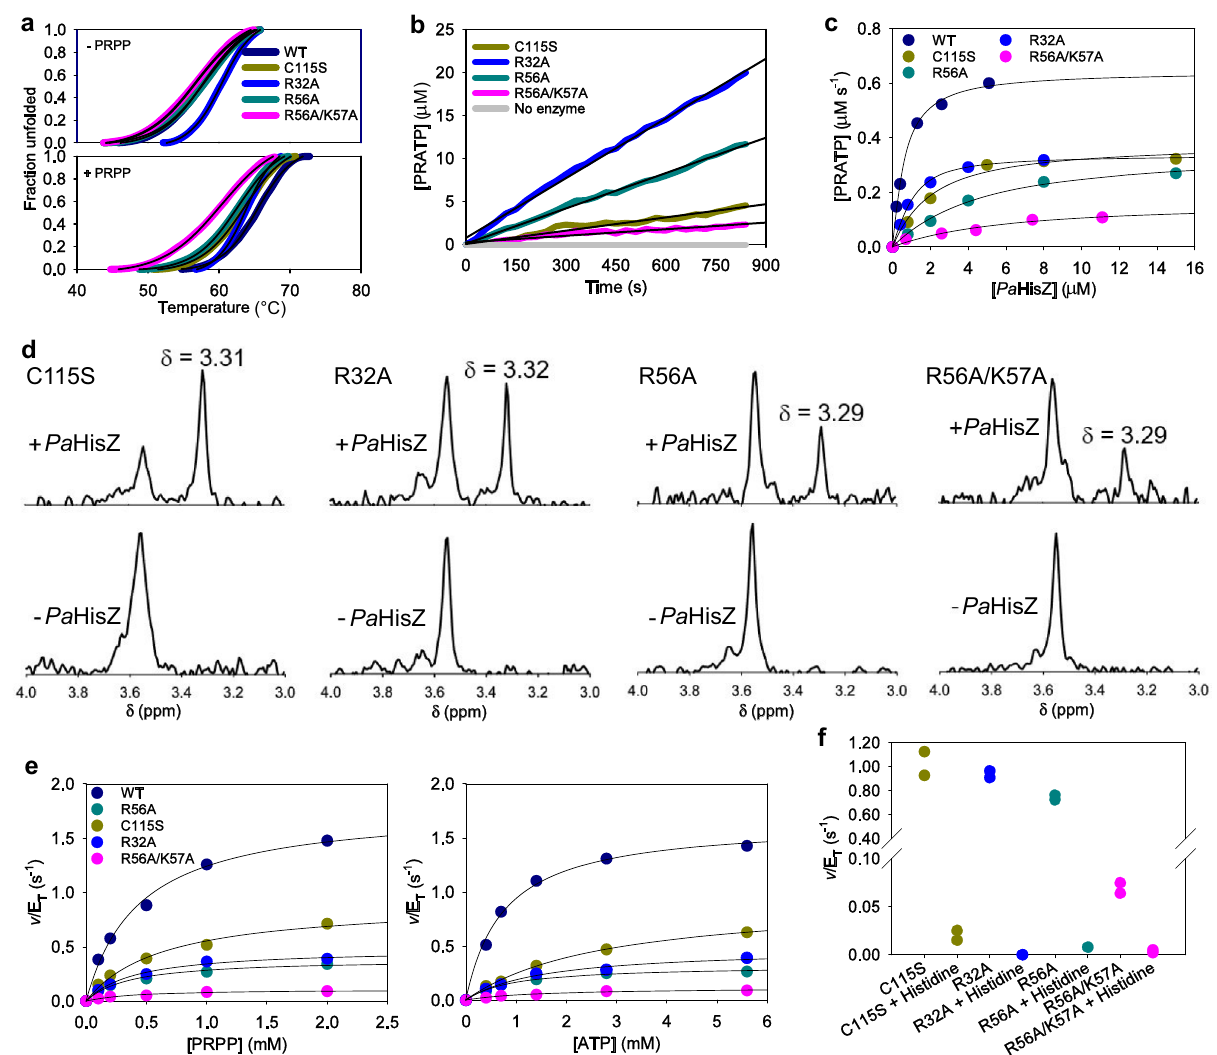
Fig. 2 | Allosteric rescue of catalytically impaired Pa HisG S mutants by Pa HisZ. provided as a Source Data fi le. d Close-ups of the 4.0 – 3.0ppm region of the 31 P-NMR spectra of the reaction catalysed by Pa HisG S mutants in the presence and a DSF-based thermal denaturation of C115S-, R32A-, R56A-, or R56A/K57A- Pa HisG S . Tracesareaveragesof threeindependentmeasurements.Linesofbest fi tto Eq.(2) absenceof Pa HisZ.Thepeakat~3.30ppmcorrespondstothephosphorusinthe N 1 - 5-phospho- β -D-ribose moiety of PRATP 28,29 . Source data are provided as a Source areinblack.SourcedataareprovidedasaSourceData fi le. b PRATPformationtime course catalysed by 10 μ M Pa HisG S variants. Traces are averages of two indepen- Data fi le. e Substrate saturation curves forWT and mutant Pa ATPPRT. Data are the dent measurements. Black lines are linear regressions of the data. Source data are mean of two independent measurements. Lines are best fi t of the data to Eq. (1). provided as a Source Data fi le. c Dependence of rate of reaction catalysed by Source dataareprovidedas aSourceData fi le. f Effectof1mM histidine onmutant Pa HisZ. Data are the mean of two inde- Pa HisG Pa ATPPRT-catalysed reaction. Two independent measurements were carried out, S variants on the concentration of pendent measurements. Lines are best fi t of the data to Eq. (3). Source data are and all data points are shown. Source data are provided as a Source Data fi